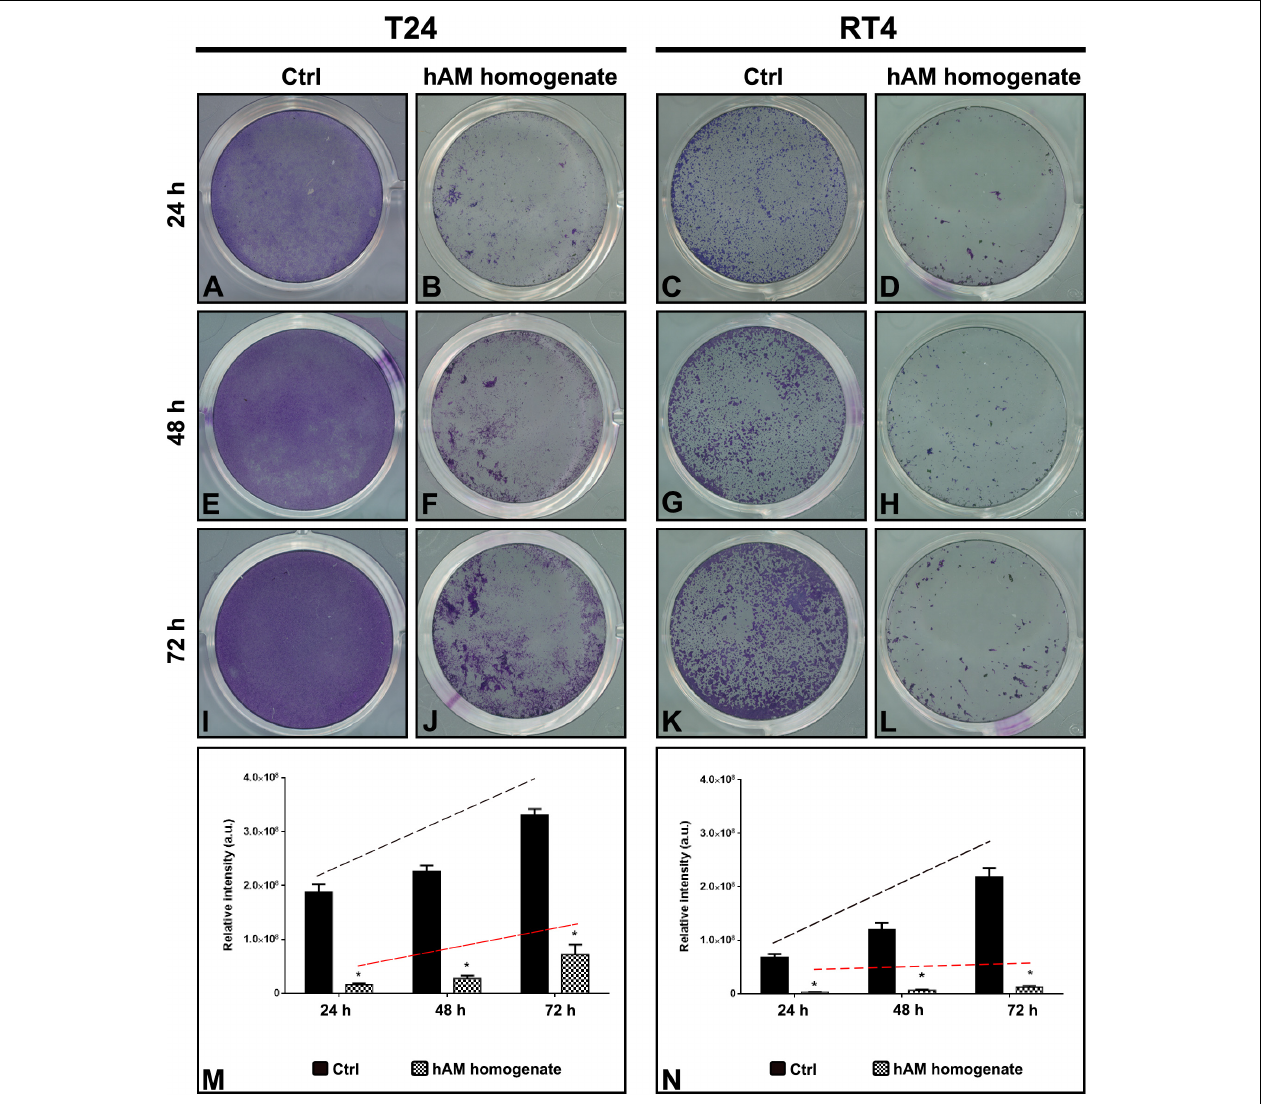
FIGURE 4 | Human amniotic membrane (hAM) homogenate inhibits the cell attachment of T24 and RT4 cells and hinders their growth dynamics. (A,B) hAM homogenate significantly reduced the ability of T24 cells to attach to the culture surface after 24-h incubation. (C,D) hAM homogenate significantly reduced the ability of RT4 cells to attach to the culture surface after 24-h incubation. (E,F,I,J) hAM homogenate strongly inhibited the growth dynamics of the adhered T24 cells 48- and 72-h after the cell seeding. (G,H,K,L) hAM homogenate strongly inhibited the growth dynamics of the adhered RT4 cells 48- and 72-h after the cell seeding. (M,N) Quantitative analysis of the relative intensity of adherent T24 and RT4 cells. The regression line of the untreated cells (black dashed line) has a steeper upward tilt in comparison with the regression line of cells treated with hAM homogenate (red dashed line). The quantified data here is presented as a mean relative intensity ± standard error of the mean (SEM). Data were obtained from three distinct experiments, each performed with a different biological sample of hAM. Within each experiment, three technical replicates were carried. * p <